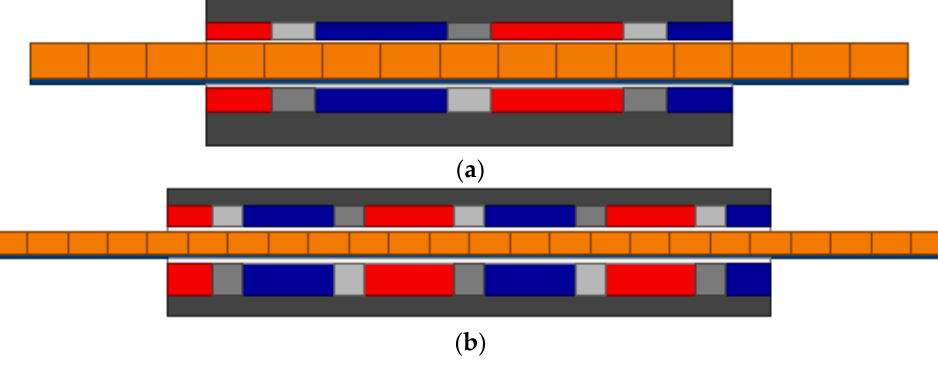
Figure 15. Axisymmetric view of the electromagnetic actuator for: ( a ) the uncoupled model with P = 4, N CPMs = 0.4, N PMi = 0.6, τ r / τ p = 0.75, and n form = 1.1633, and n BI = 0.4; ( b ) coupled model with P = 6, N CPMs = 0.25, N PMi = 0.6, τ r / τ p = 0.75, = n form = 0.7961, and n BI = 0.4.